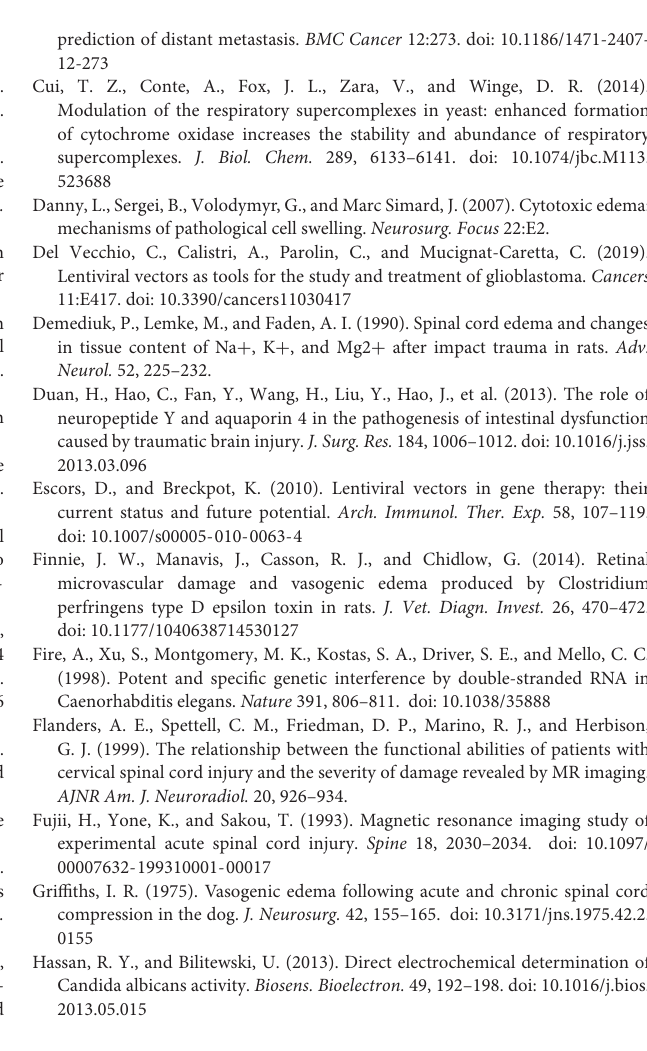
FIGURE S2 | Prepare models of SCC. FIGURE S3 | Rats hindlimb motor dysfunction–model preparation succeeded. FIGURE S4 | Spinal cords were inflicted by an Infinite Horizon Device. TABLE S1 | Analysis of BBB score after AQP4-RNAi. TABLE S2 | Analysis of BBB score after SCC. TABLE S3 | Analysis of neurons areas after SCC. TABLE S4 | Analysis of qRT-PCR results. TABLE S5 | Analysis of wet-dry weight after SCC. TABLE S6 | The expression of AQP4 and COX5A in Western blot after